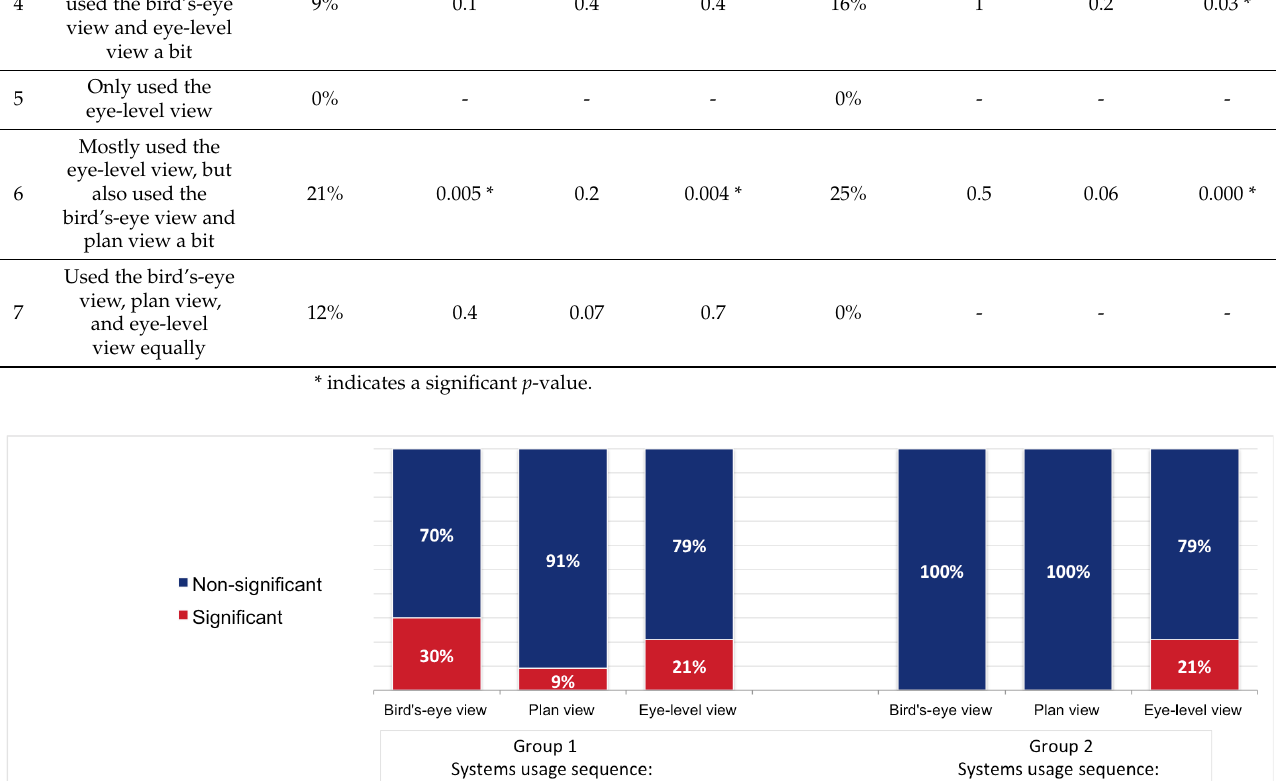
Table 2 . Differences between the Perceived and Actual View Usage Patterns based on System Us- age Sequence.